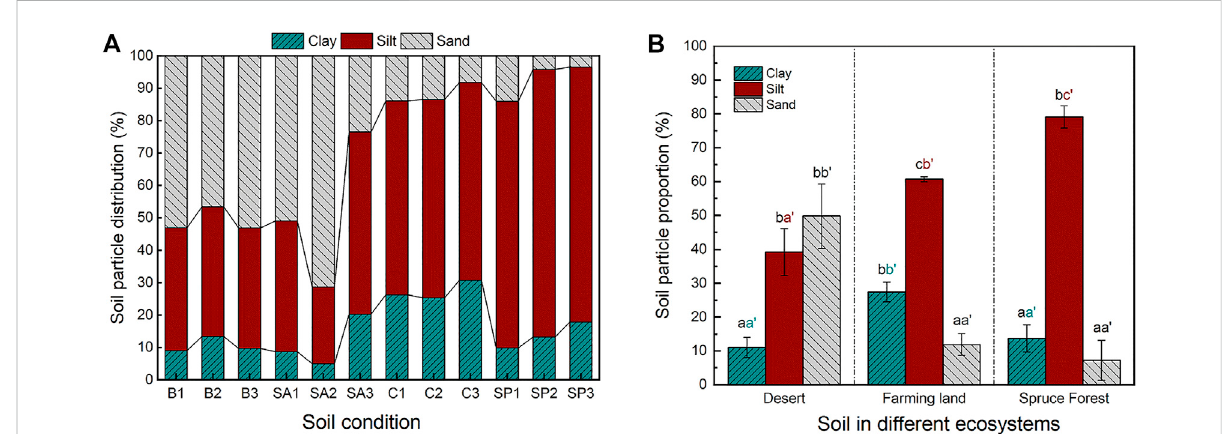
FIGURE 1 (A) The particle distribution of the soils under different vegetation; (B) the comparison of soil particle distribution in different ecosystems. The small letters in black in Figure 1B denote the signi fi cance ( p < 0.05) of different types of soil particles within the same ecosystem, while the small